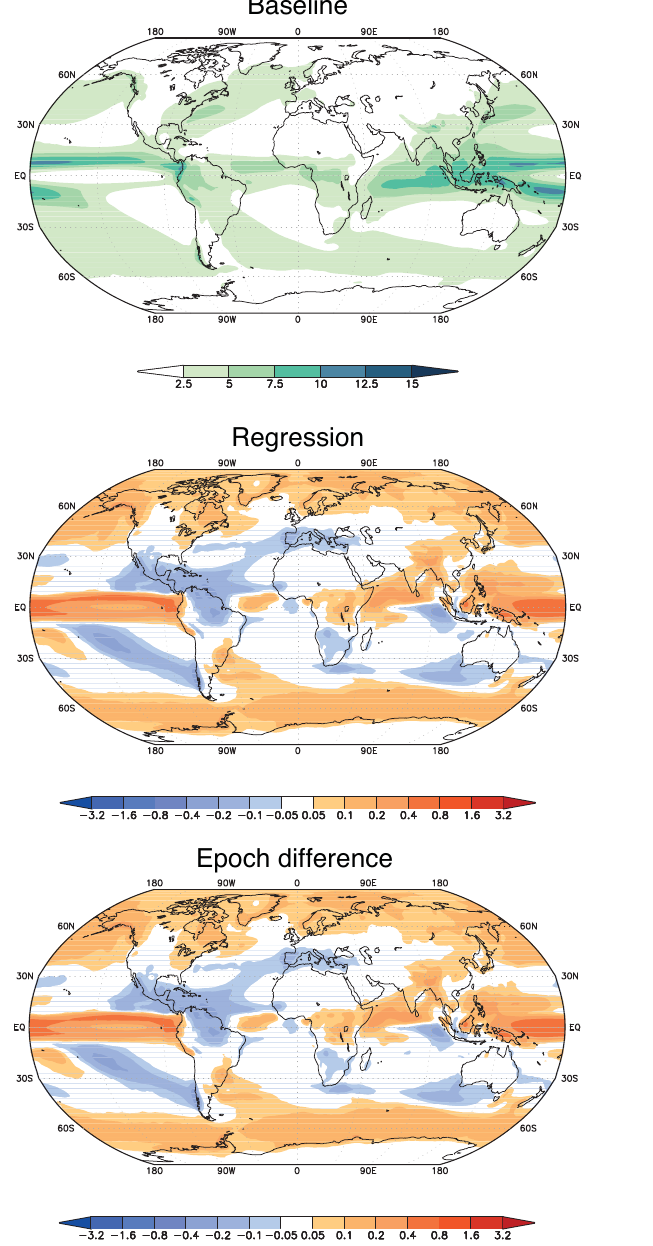
Figure 1. The components needed for pattern scaling of the pre- cipitation response to CO 2 forcing, averaged over the 13 models in group 1 (Table 1). Top shows the baseline precipitation pattern for the multi-model average: B(x, 0 ) in Eq. (1) (mmday − 1 ; averaged over years 1–25 of the 1pctCO2 simulation). The other panels show the time-invariant pattern P( x ) in Eq. (1) (mmday − 1 K − 1 ) for the regression method (middle) and the epoch-difference method (bot- tom).